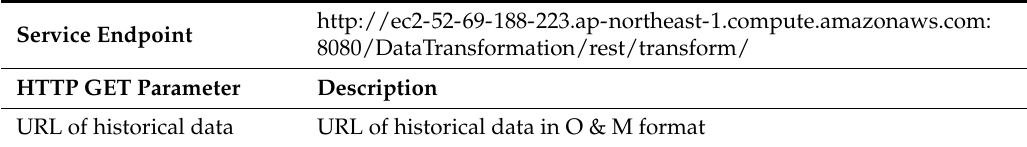
Table 7. Request parameter of the DisAg